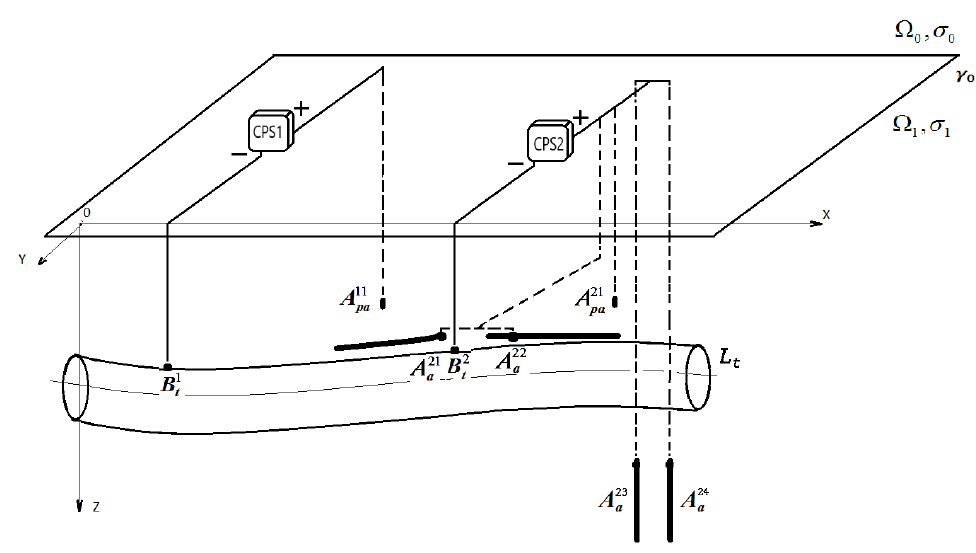
Figure 1. Scheme of cathodic protection in homogeneous isotropic half